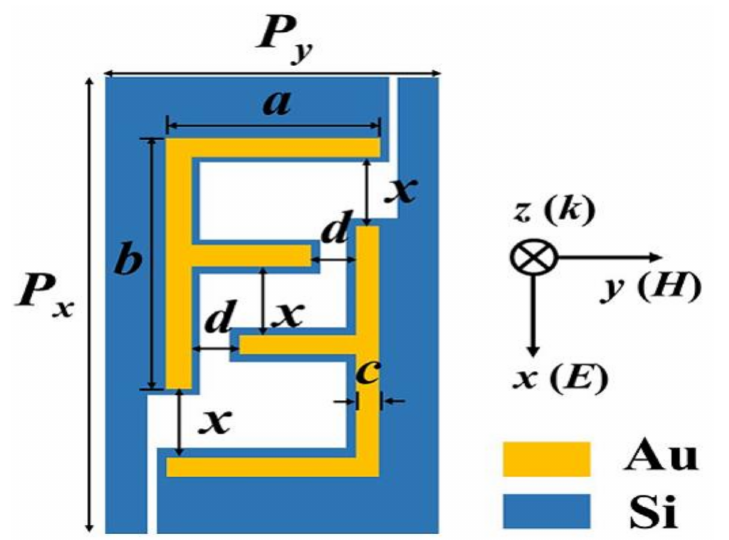
Figure 2. Schematic representation of the F-shaped THz resonator (Figure 1 of Ref.